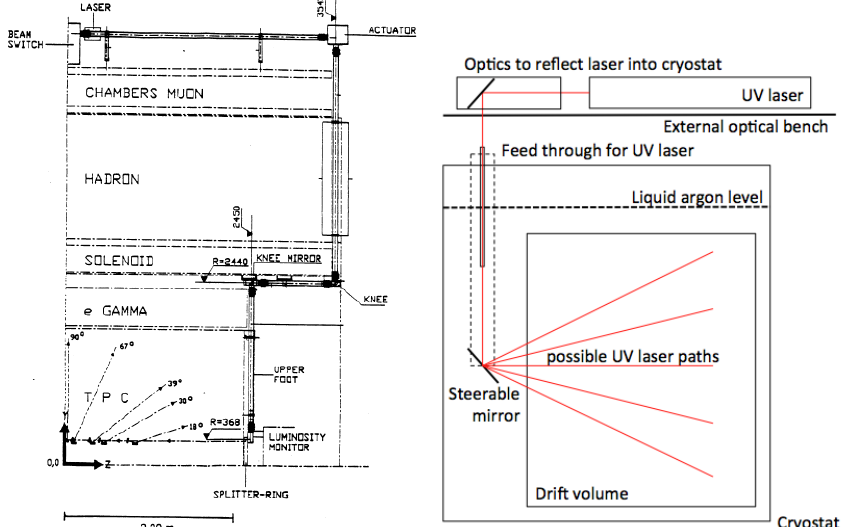
Figure 3. ( left ) Schematics of the ALEPH TPC laser calibration systems. Reused with permission from [20]. ( right ) Schematics of the MicroBooNE TPC laser calibration system. Reproduced with permission from